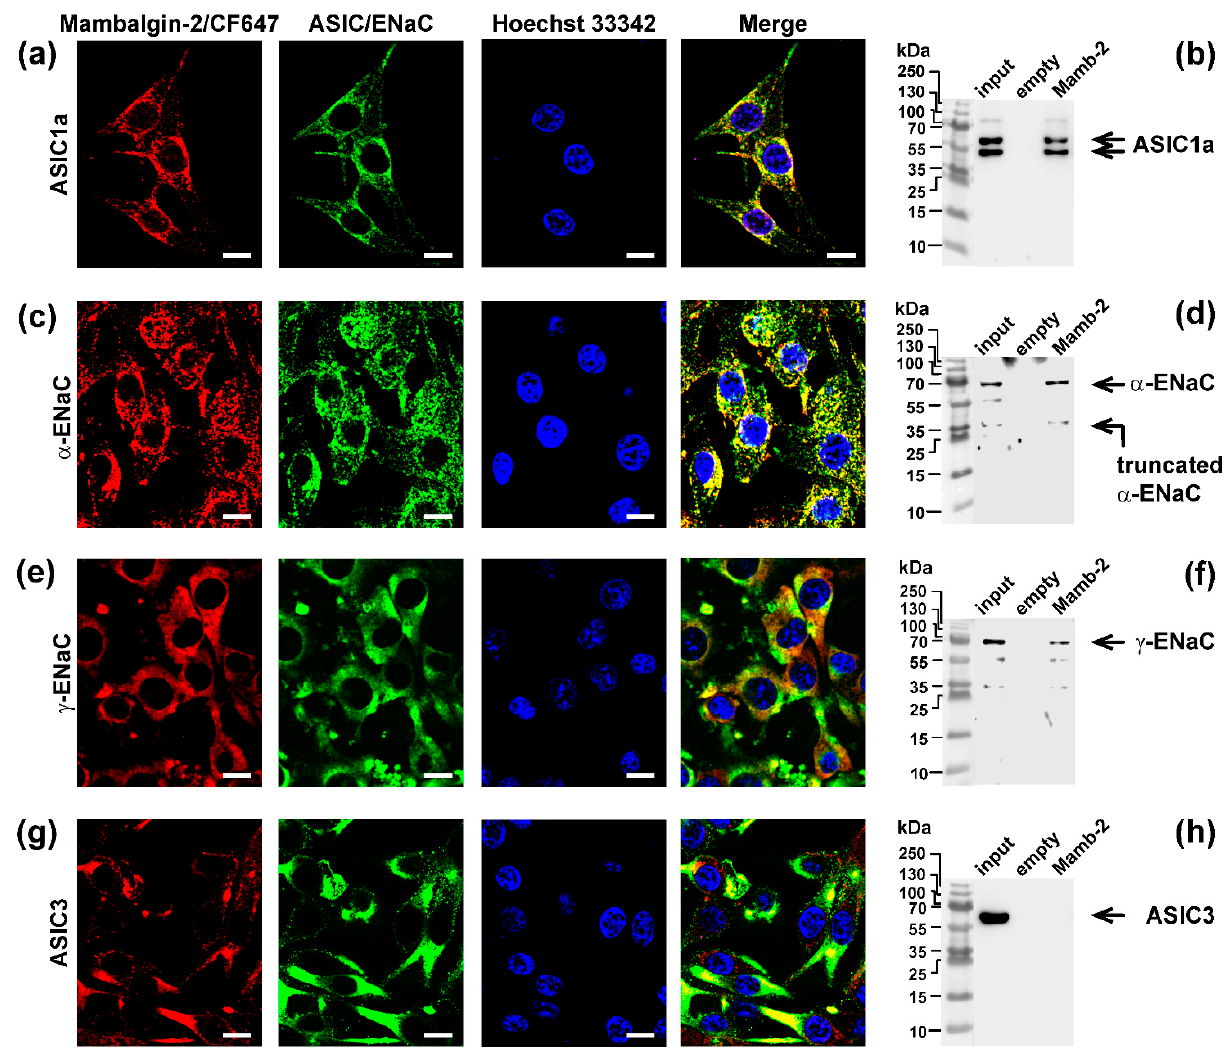
Figure 9. Investigation of mambalgin-2 interaction with the ASIC1a ( a , b ), α -ENaC ( c , d ), γ -ENaC ( e , f ), and ASIC3 ( g , h ) subunits in mel P cells: localization of fluorescently-labelled mambalgin-2/CF647 (red) and Alexa488-labeled ASIC1 ( a ), α -ENaC ( c ), γ -ENaC ( e ), and ASIC3 ( g ) subunits (green). Nuclei were stained by Hoechst 33342 (blue), scale bar 10 µ m. Western blot analysis of the ASIC1 ( b ), α -ENaC ( d ), γ -ENaC ( f ), and ASIC3 ( h ) subunits extraction from membrane fraction of mel P cells by affinity chromatography on NHS-sepharose resin coupled with mambalgin-2 ( n = 3).